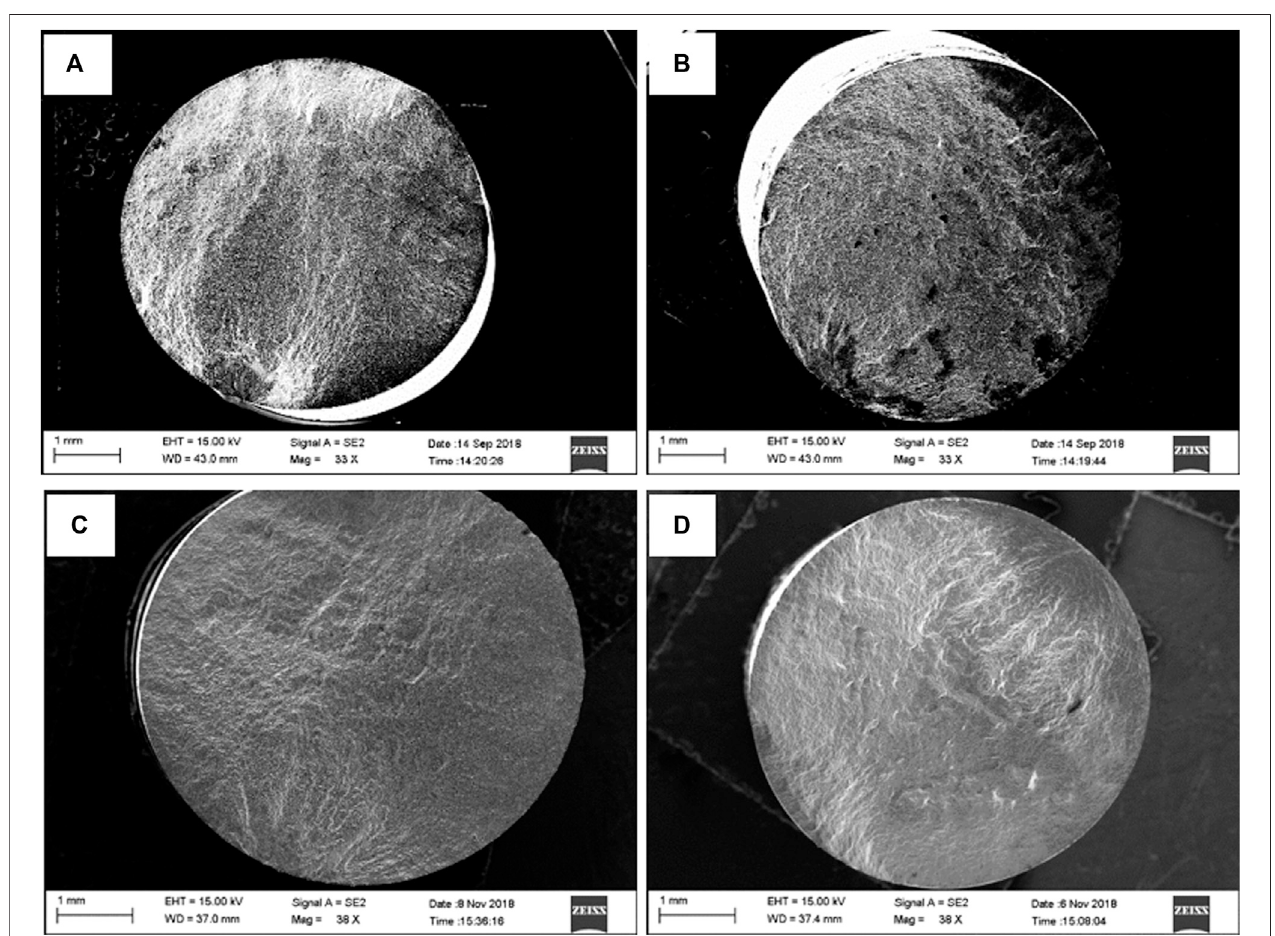
FIGURE 6 | Macroscopic view of the fatigue fracture surface of the alloy in different conditions and stress amplitudes, (A) T1-160 MPa, (B) T4-160 MPa, (C) T4- 190 MPa, (D) T6-190 MPa.